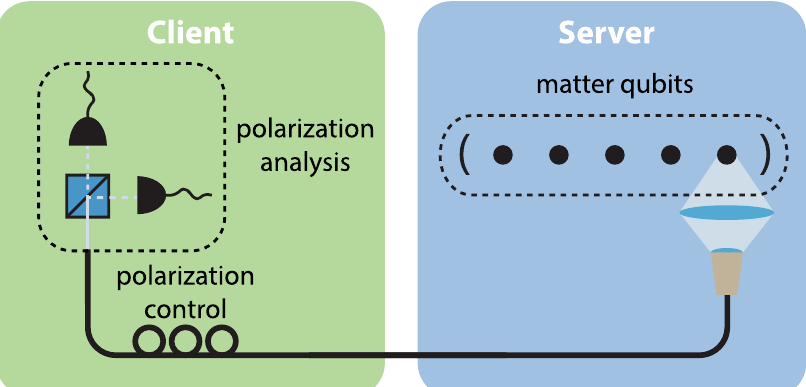
Fig. 8 Hybrid architectures combining matter qubits contained in the server with optical qubits for communication present a possible path to overcoming some of the hurdles faced by the current generation of experiments. One potential approach is to make use of trapped ions or similar matter qubits to perform the computation which can emit photons entangled with the matter system. Using the remote state preparation approach described in Section IIIC, measurements made by the client could then be used to remotely establish correlations with the matter qubits in the server suf fi cient to implement UBQC-like protocols. In the example depicted above the state of the matter qubits is taken to be entangled with polarization degree of the photon, however other degrees of freedom could also be used. The ability to create such entangled states between matter and photonic qubits has already been demonstrated for a number of systems. 79,